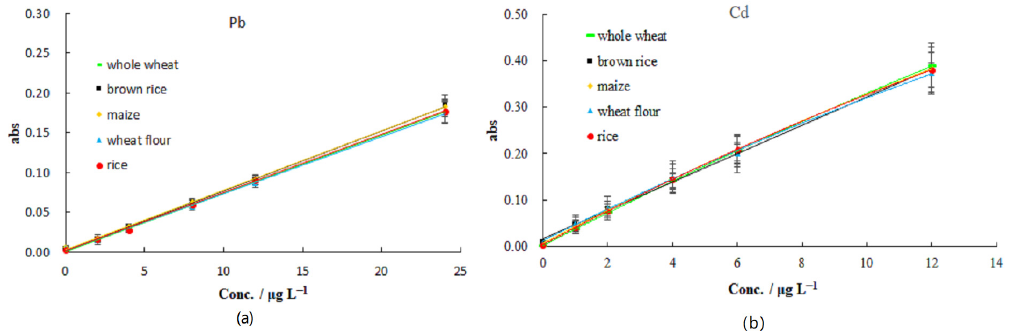
Figure 7. The different matrix matching standard curves (n = 5): ( a ) Pb and ( b ) Cd.